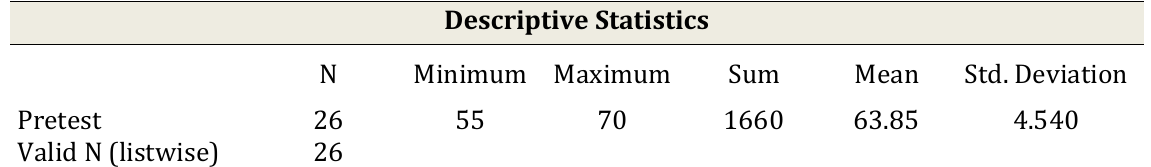
Table 4.3. Mean Score of Students ’ in Pretest Result